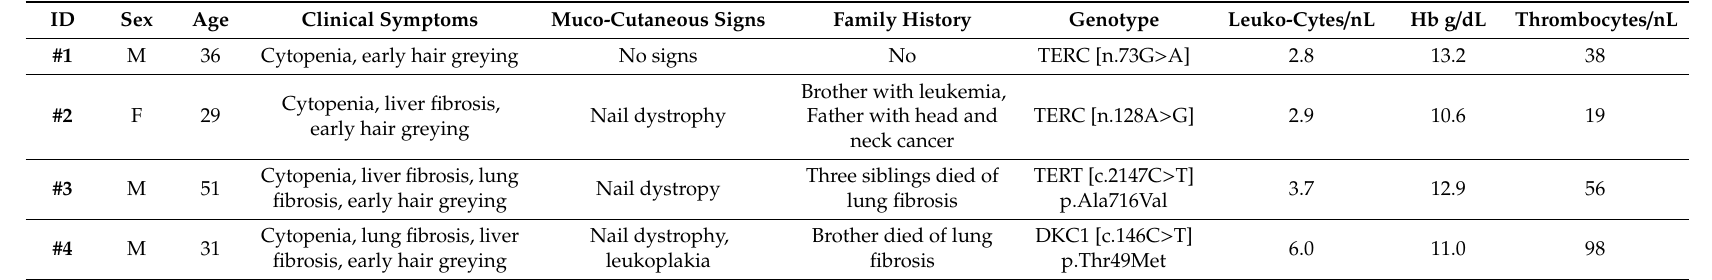
Table 1. Clinical characteristics of the three analyzed patients. M: male; F: female. The age is given in